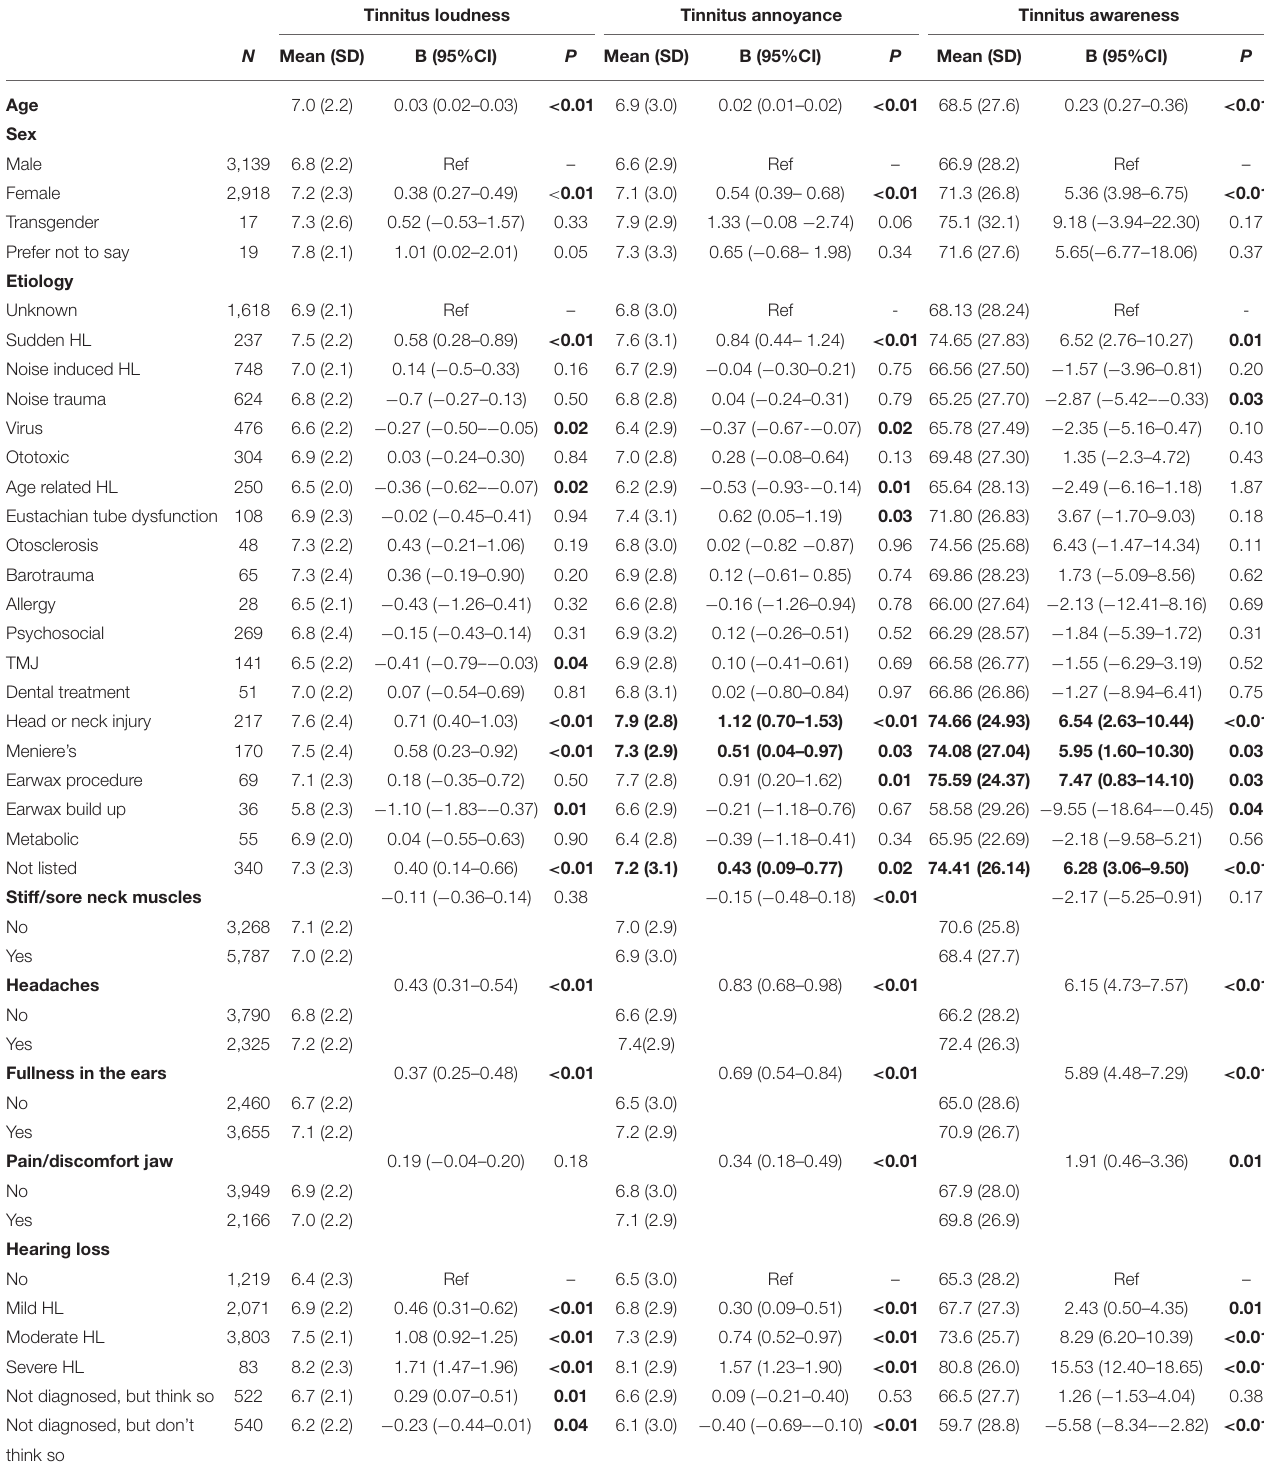
TABLE 5 | Outcome of univariate regression analysis of effect of demographics, etiology, and physical factors/comorbidities on experienced impact of tinnitus during the past week (survey physical links). Tinnitus loudness Tinnitus annoyance Tinnitus